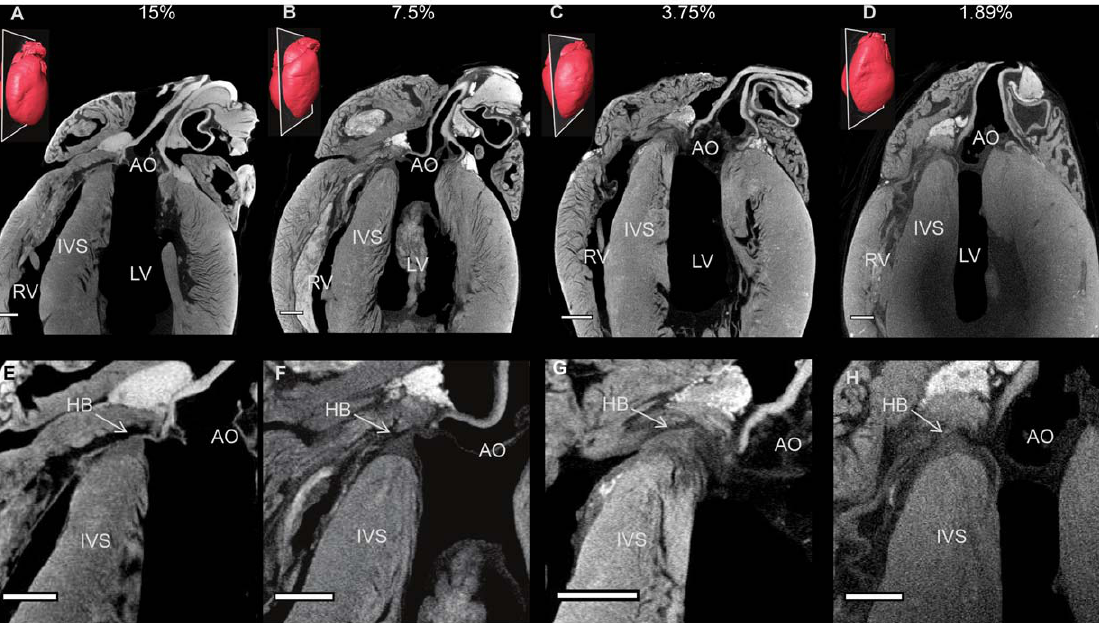
Figure 1. Optimization of the micro-CT imaging technique. Longitudinal micro-CT images (A-D), through 4 rat hearts stained with 15, 7.5, 3.75 and 1.87% concentrations of I 2 KI respectively. Corresponding high power images focussing on the atrioventricular conduction axis (E-H). Inset 3D renderings of each heart show the associated planes of interest. AO- aorta, IVS- inter-ventricular septum, HB- His bundle, LV- left ventricle, RV- right ventricle. (scale bar represents 1 mm).